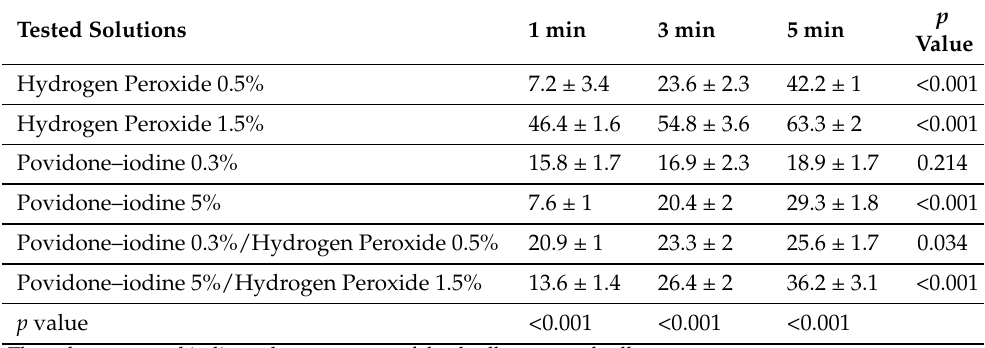
Table 3. Toxicity data in tenocyte